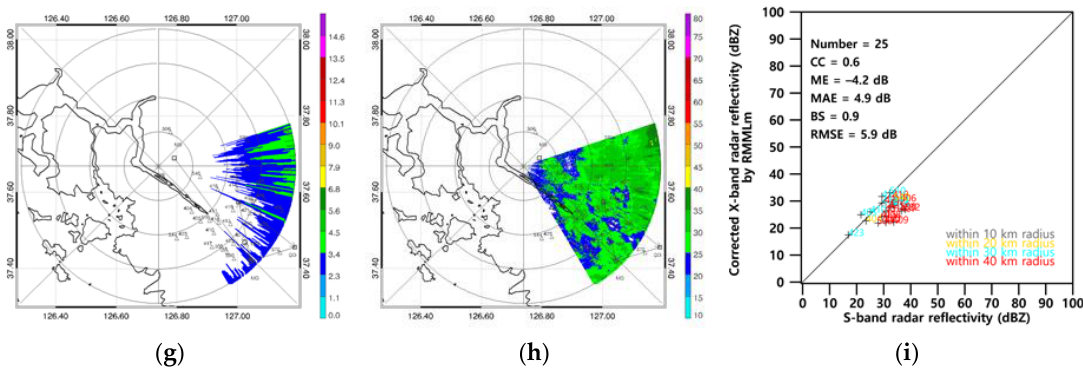
Figure 6. Same as Figure 5 but for the stratiform case.